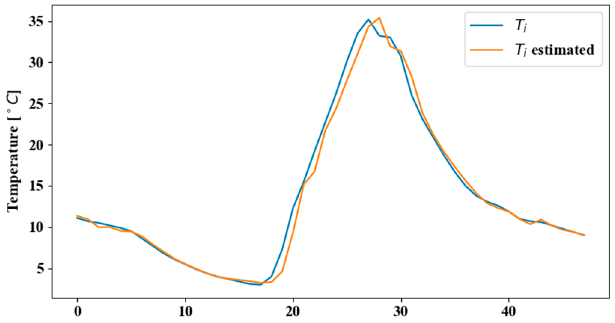
Figure 30. Estimated indoor vs. measured indoor temperature for the validation set (first experiment).